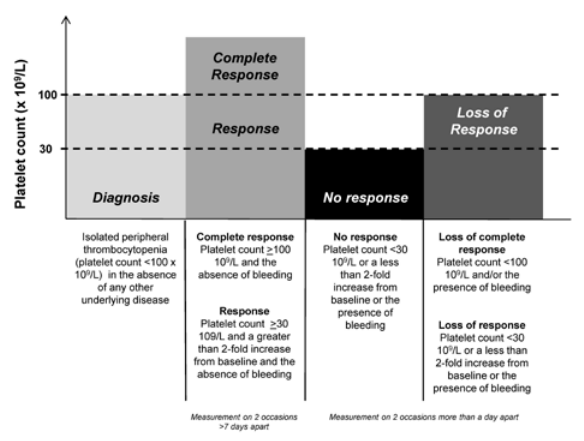
Figure 1: 2011 ASH criteria for ITP treatment